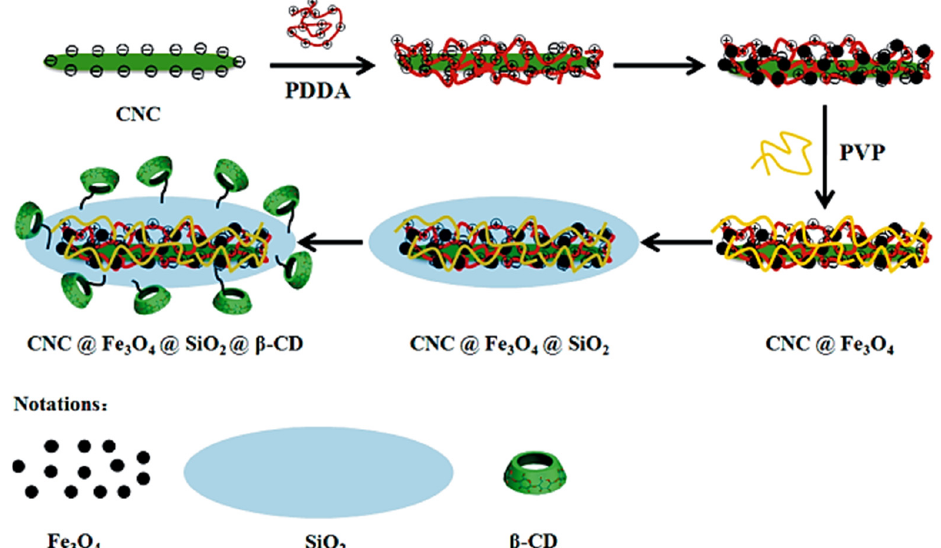
Figure 19. The schematic presentation for the synthesis of the CNC@Fe 3 O 4 @SiO 2 @ β -CD a . Reprinted with permission from [353]. Copyright 2014 American Chemical Society. a CNC: cellulose nanocrystal. PDDA: poly(diallydimethylammonium chloride). PVP: polyvinylpyrrolidone. β -CD: β -cyclodextrin.